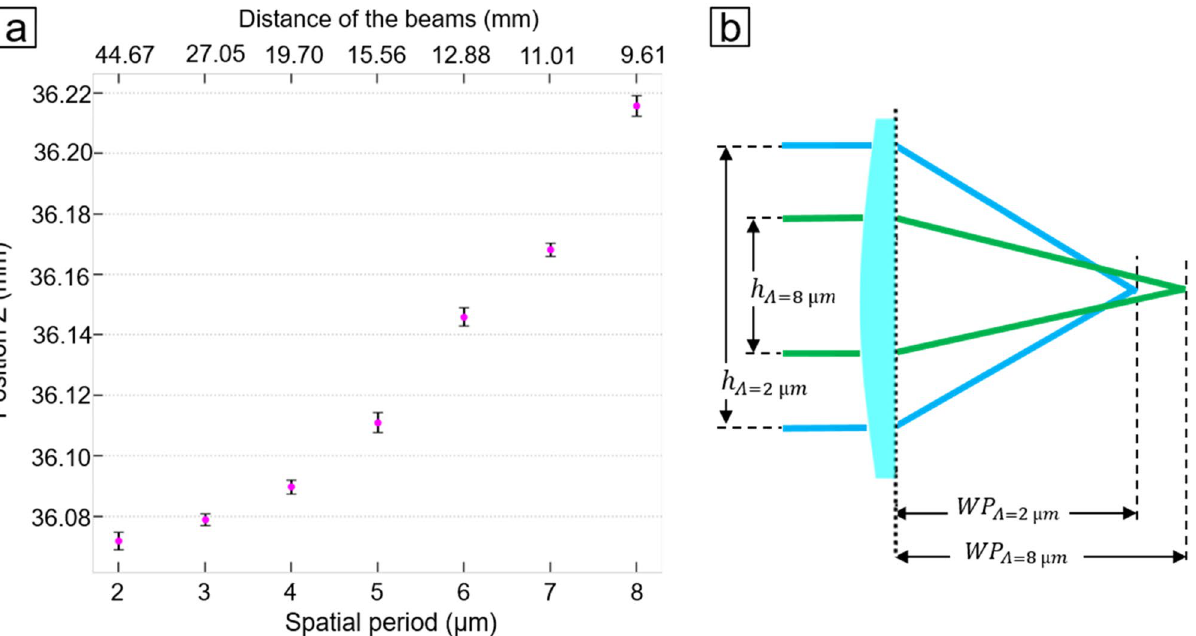
Figure 6. ( a ) Shift of the working position of the interference volume by changing the spatial period for pulse energy 255 µJ, ( b ) Illustration of the working position shift for two different spatial